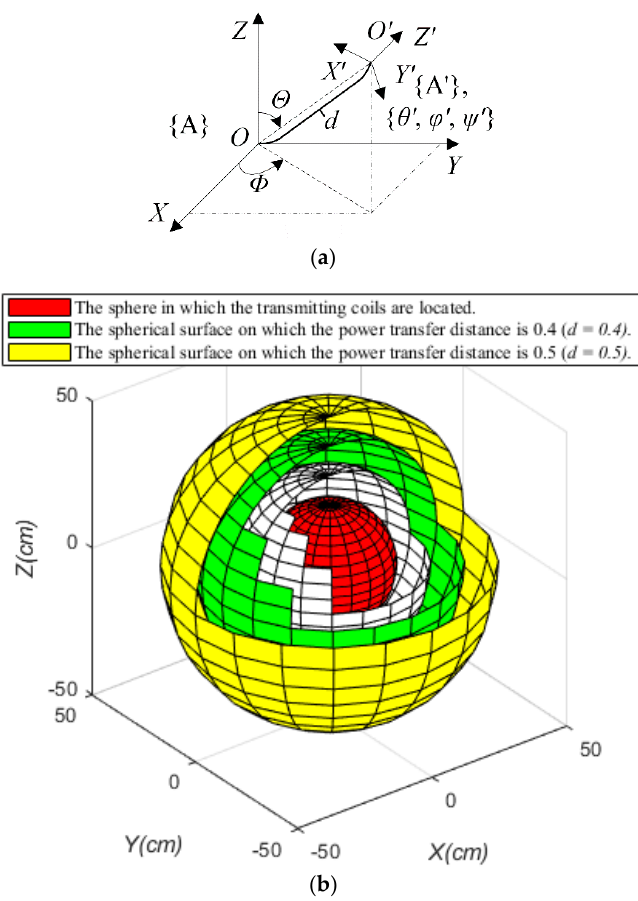
Figure 7. The coordinate system and power transmission space of omnidirectional WPT system: ( a ) center relationship between the transmitting coils and the receiving coil and ( b ) space division.